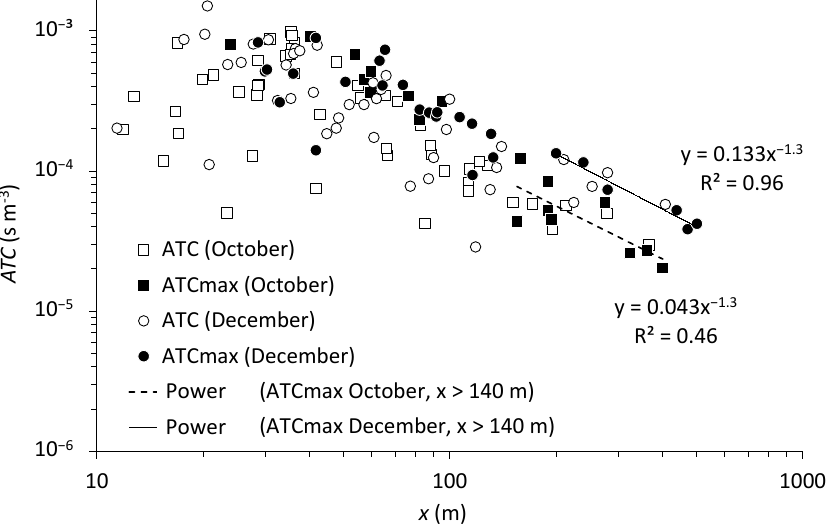
Figure 4. Atmospheric transfer coefficients 𝐴𝑇𝐶 measured at a height of 0.15 as a function of distance 𝑥 from the discharge point.